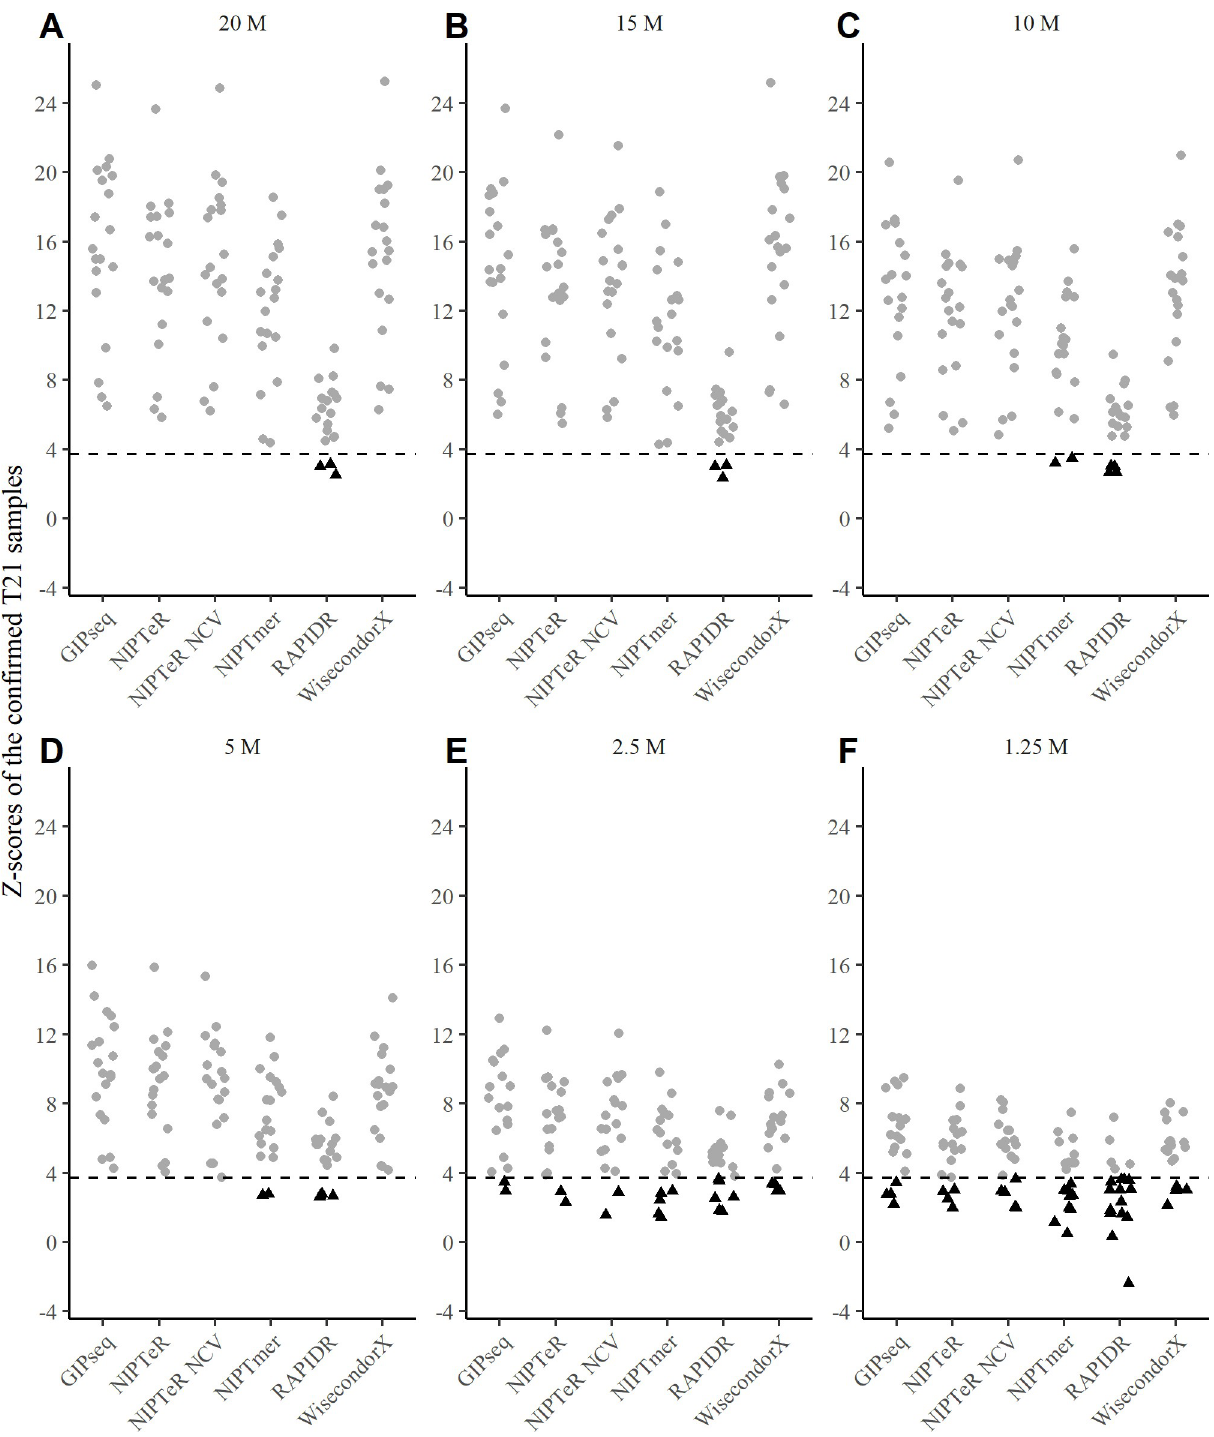
Fig 2. Z-scores of clinically validated T21 samples across a range of sequencing depths. Z-scores of known trisomy samples at sequencing depths of 20M RPS (A), 15M RPS (B), 10M RPS (C), 5M RPS (D), 2.5M RPS (E), and 1.25M RPS (F) are shown. Undetected (false negative) trisomies falling below the Z cut-off thresholds (black dashed line in each graph) are represented as black triangles. t